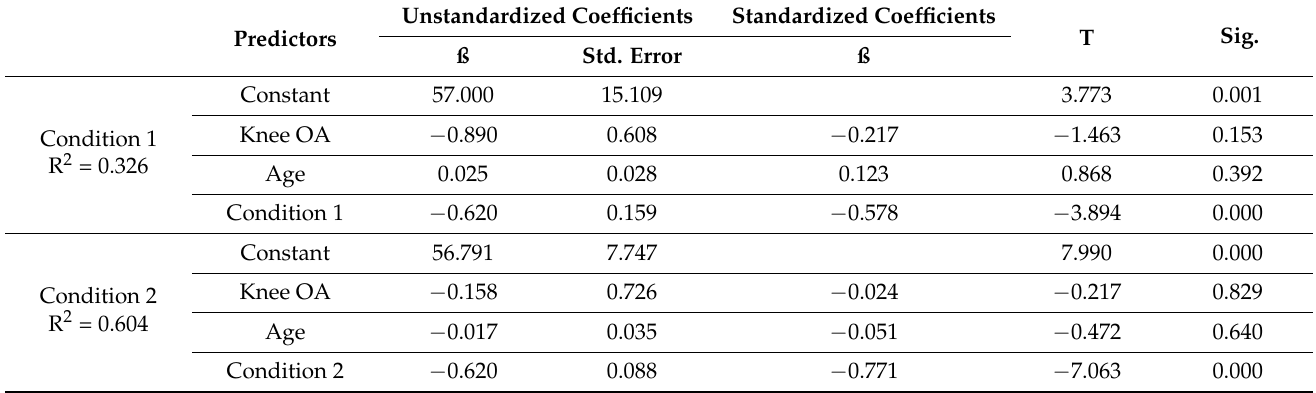
Table 4. Comparison of the effects of textured